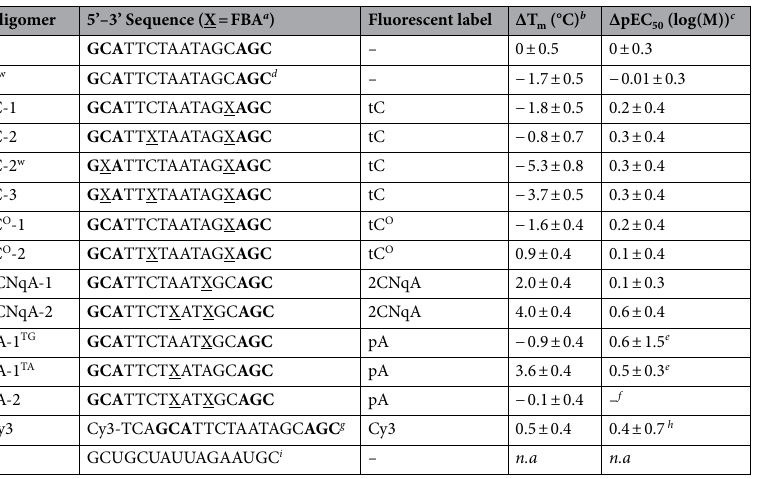
Table 1. Gapmer sequences, gapmer:RNA melting temperatures, and knockdown efficiencies, relative to their unmodified counterpart U. Bold font denotes cEt sugars; all gapmers have phosphorothioate backbones throughout the sequence. a The sugar moiety in the FBA nucleotides is deoxyribose. b Difference in melting temperature compared to the unmodified gapmer U (T m (U) = 61.5 ± 0.4 °C) in 10 mM phosphate buffer (pH 7.4) with 100 mM NaCl and 1.0 mM EDTA added, mean ± standard deviation of four melting transitions. c Difference in effective MALAT1 knockdown concentration compared to the unmodified gapmer U (pEC 50 (U) = − 5.7 ± 0.2, EC 50 unit: M), mean ± standard deviation of duplicate biological replicates run on at least two occasions. d Gapmer U w , having one deoxyribose sugar in position 2, was included as a control for the wing-labeled FBA-gapmers tC-2 w and tC-3. e Unsatisfactory fit due to incomplete knockdown in the applied concentration range, see Supplementary Fig. S22. f Unable to fit data. g Cy3 was conjugated to the 5’ end of the gapmer via a DBCO-type click linker (Supplementary Fig. S14). h The Cy3 gapmer was evaluated in a biological duplicate on one occasion and the pEC 50 was referenced to the unmodified gapmer U included in the same experiment (Supplementary Fig. S23). i Target sequence, all